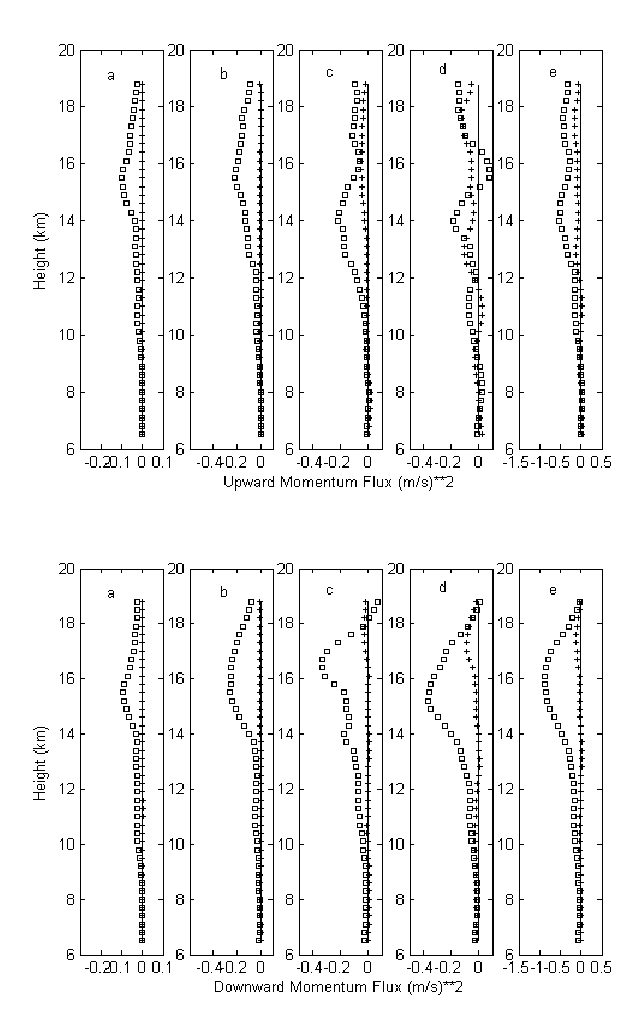
Fig. 2. Upper panel: 72h averaged profiles of upward fluxes Fig.2 Upper panel: 72 hours averaged profiles of upward fluxes of zonal- (square) and of zonal- (square) and meridional- (cross) momentum for peri- meridional- (cross) momentum for periods of (a) 10- 30 min, (b) 30 min– 2 h, (c) 2- 7 h, ods of (a) 10–30min, (b) 30min–2h, (c) 2–7h, (d) 7–24h, and (d) 7- 24 h, and (e) 10 min- 24 h. The vertical straight lines are reference lines for zero (e) 10min–24h. The vertical straight lines are reference lines for zero momentum flux. Lower panel: Corresponding profiles of momentum flux. Lower panel: Corresponding profiles of downward fluxes. downward